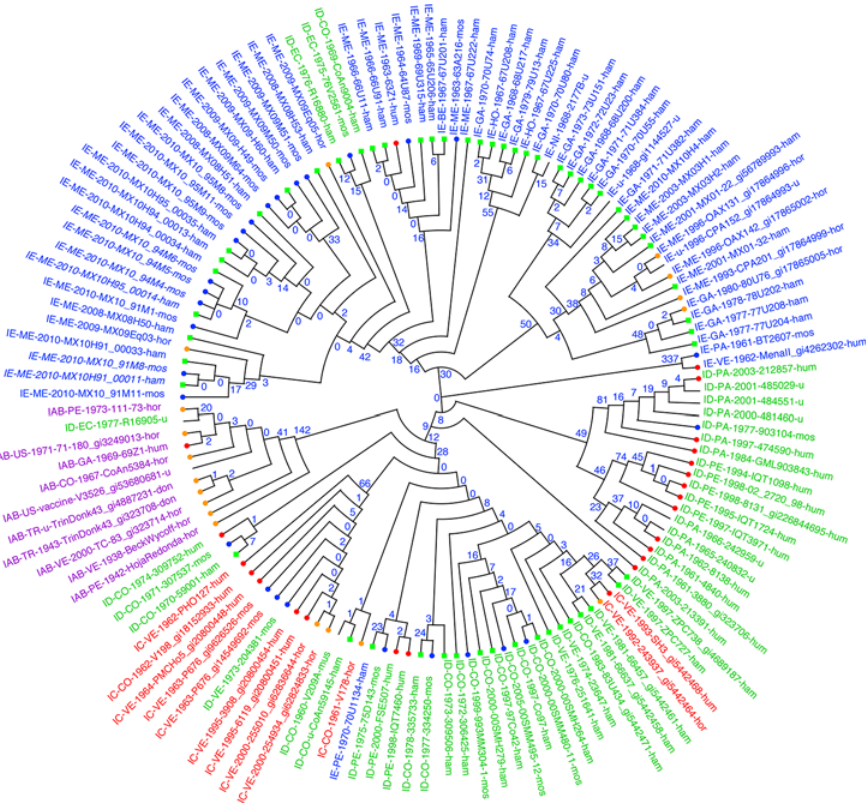
Fig 1. SNP phylogeny of VEEV isolates by parsimony. Strains are labeled by serotype-country-year collected-strain-host. Country codes are GA = Guatemala, PE = Peru, NI = Nicaragua, VE = Venezuela, CO = Colombia, TR = Trinidad, PA = Panama, US = USA, EC = Ecuador, ME = Mexico, BE = Belize, HO = Honduras, BR = Brazil, AR = Argentina, FG = French Guiana. Host codes are hor = horse, don = donkey, hum = human, mos = mosquito, ham = hamster, mus = mouse. u = unknown. Strains are colored by serotype (blue = IE, green = ID, red = IC, and purple = IAB). Hosts from which the strains were collected are indicated with symbols at the branch tips (red circles = human, orange circles = horses, blue circles = mosquitos, and green squares = hamsters). Counts of the number of alleles shared uniquely by the sequences down each branch are shown at the nodes in